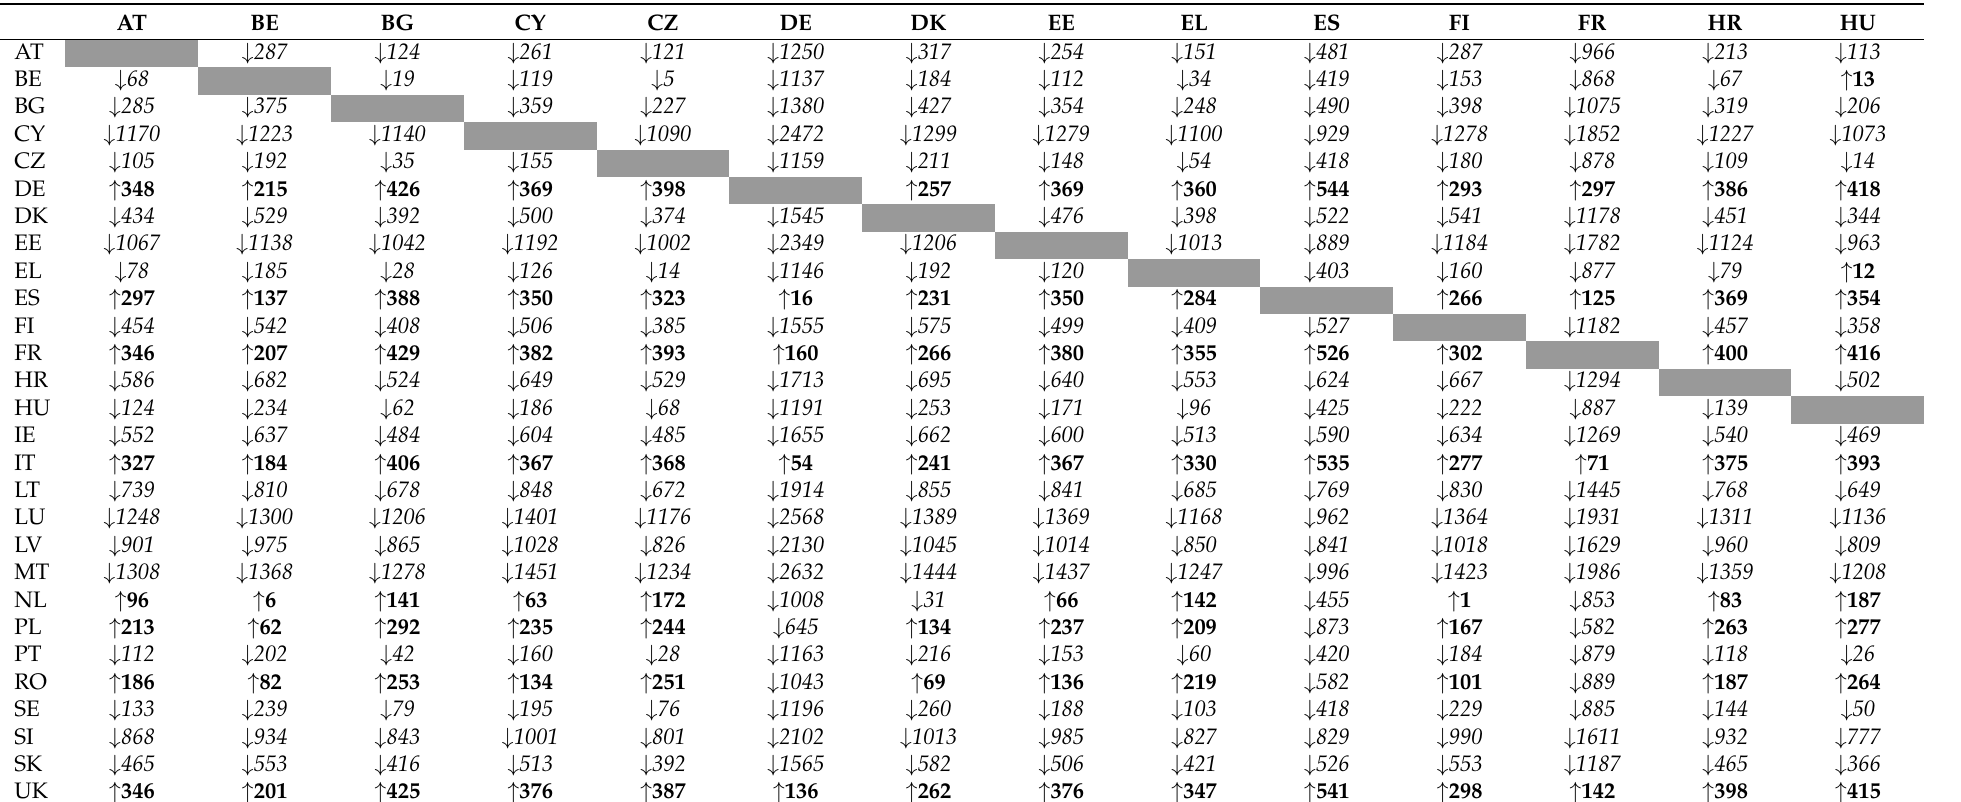
Table A1. The impact of any member state leaving the 28-member European Union with populations for 2015.